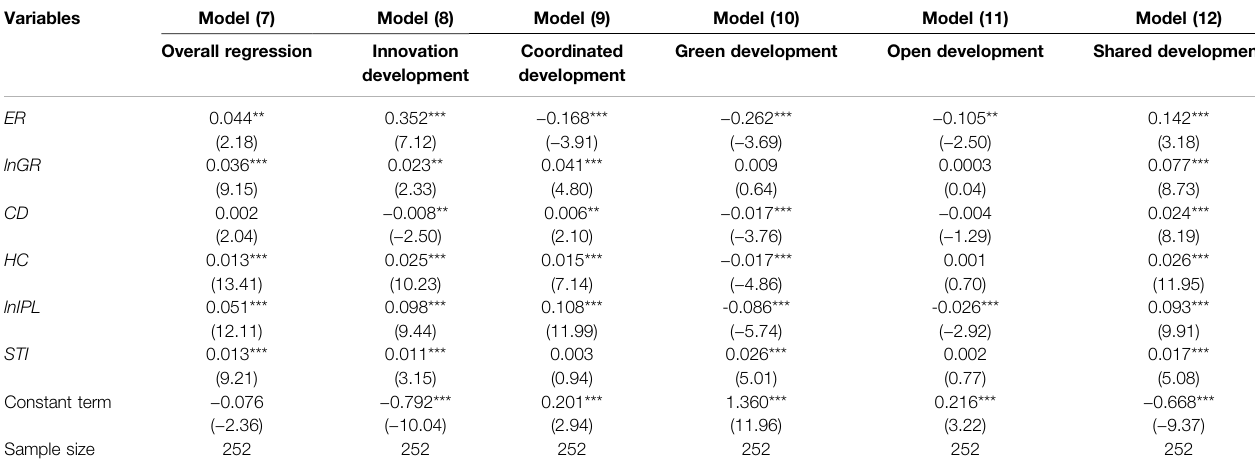
TABLE 6 | Robustness test estimates - exclude 2008